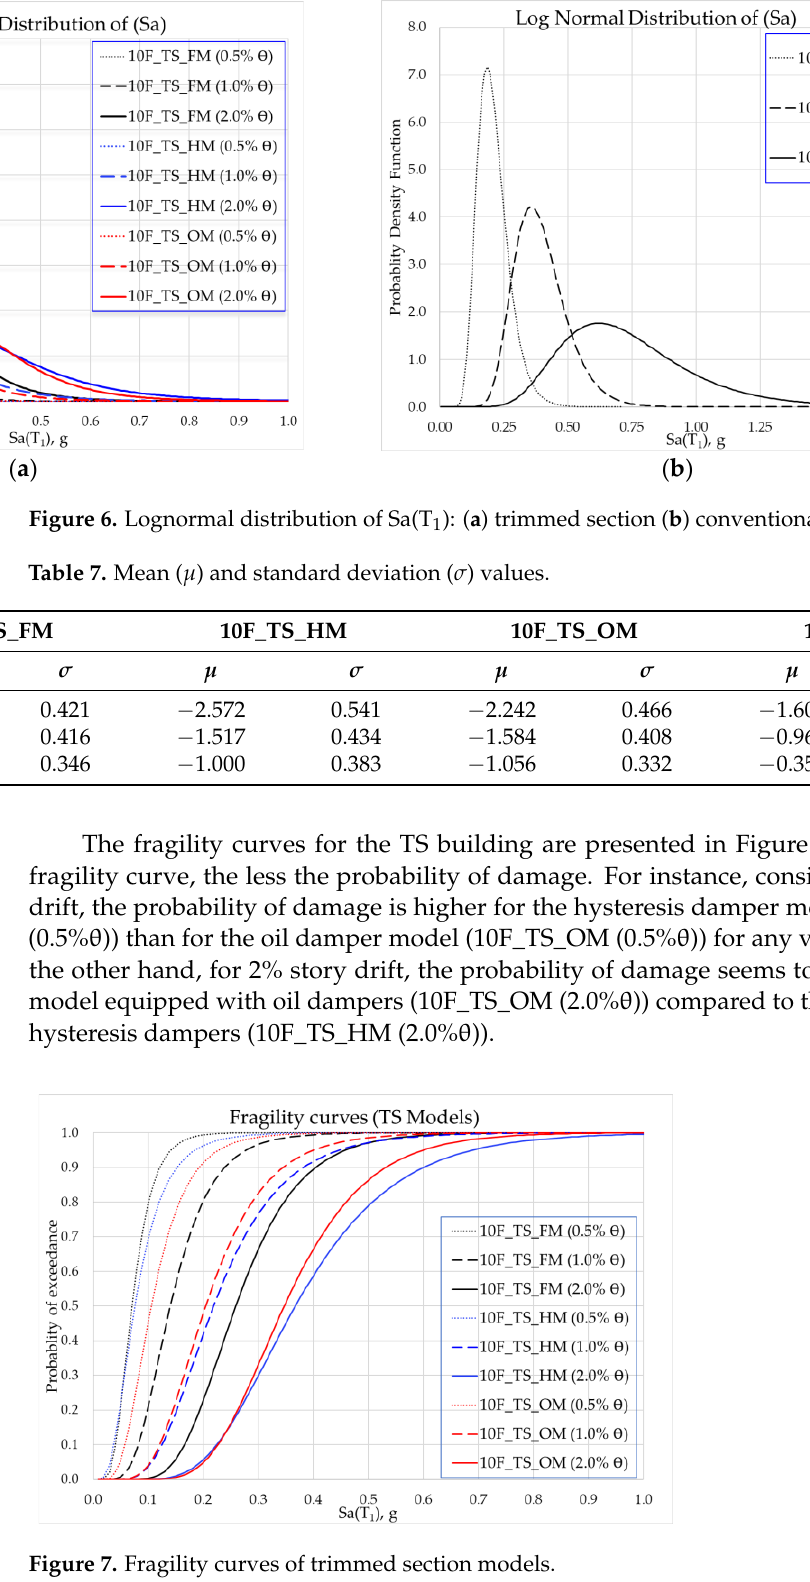
10 of 15 Figure 5. IDA curves for models: ( a ) 10F_TS_FM, ( b ) 10F_TS_HM, ( c ) 10F_TS_OM, ( d ) 10F_CS_FM. 3.4. Fragility Curves Analyzing the models with 20 GMRs provides a bunch of discrete points on an IM_DM plot. The IM values corresponding to 0.5, 1.0, and 2.0% story drift were obtained using interpolation. By using the estimated mean and standard deviation values of IM, the fragility curve was obtained as the lognormal cumulative distribution function expressed by Equation (1), as follows: